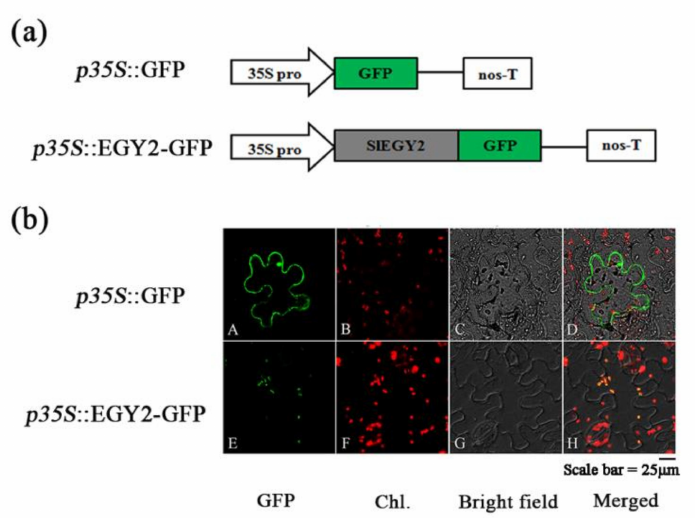
Figure 2. Subcellular localization of SlEGY2 in epidermal cells from Nicotiana benthamiana. ( a ) Schematic of the GFP recombinant plasmid. ( b ) The SlEGY2-GFP fusion protein was a tar- get to chloroplasts. (A, E) Green fluorescence of GFP (A) and the EGY2-GFP fusion protein (E); (B, F) Red autofluorescence of chlorophyll; (C, G) Bright-field images of tobacco epidermal cells. (D) Merged images of A, B, and C. (H) Merged images of E, F, and G.